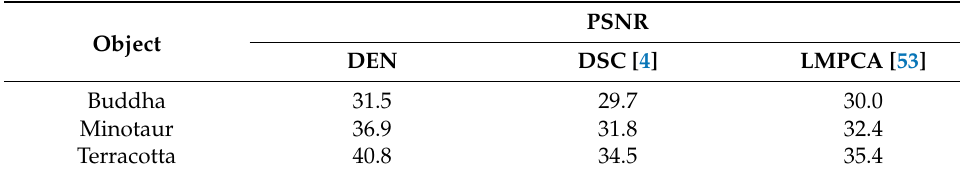
Table 1. PSNR comparison with DEN, DSC, and LMPCA. We evaluated the PSNR of each reconstruc- tion result with respect to the ground truth input tensor I .